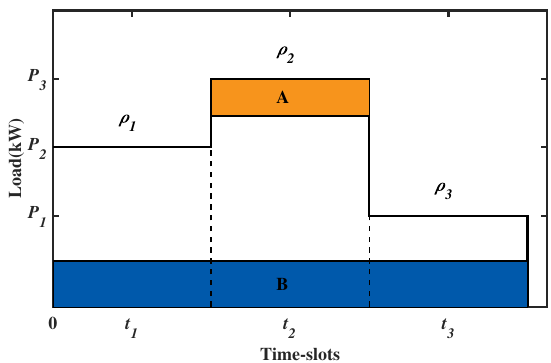
Figure 1. Hourly bidding mode and block bidding